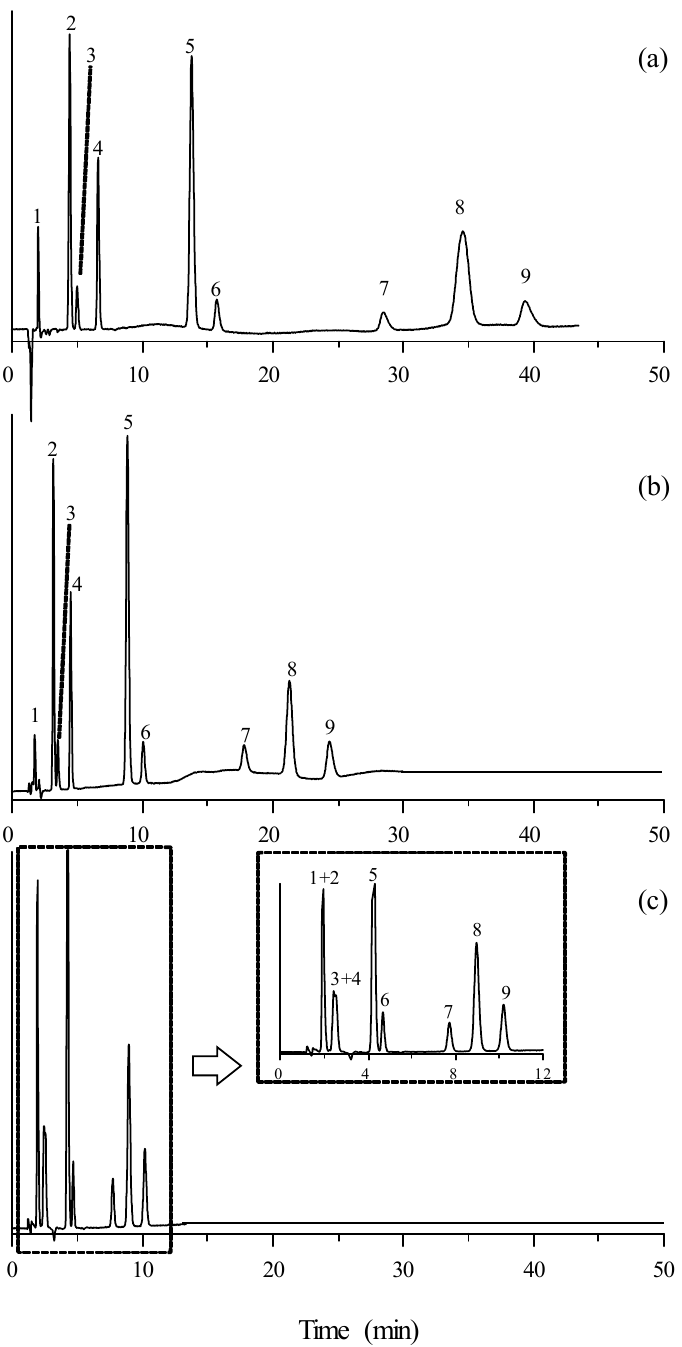
Figure 2. Chromatograms of the set of β -adrenoceptor antagonists detected at 254 nm, eluted with mobile phases containing 15% acetonitrile and 10 mM ionic liquid: ( a ) [C 2 MIM][Cl], ( b ) [C 4 MIM][Cl], and ( c ) [C 6 MIM][Cl]. Solute identity: (1) Atenolol, (2) carteolol, (3) nadolol, (4) pindolol, (5) acebutolol, (6) metoprolol, (7) esmolol, (8) celiprolol, and (9) oxprenolol.